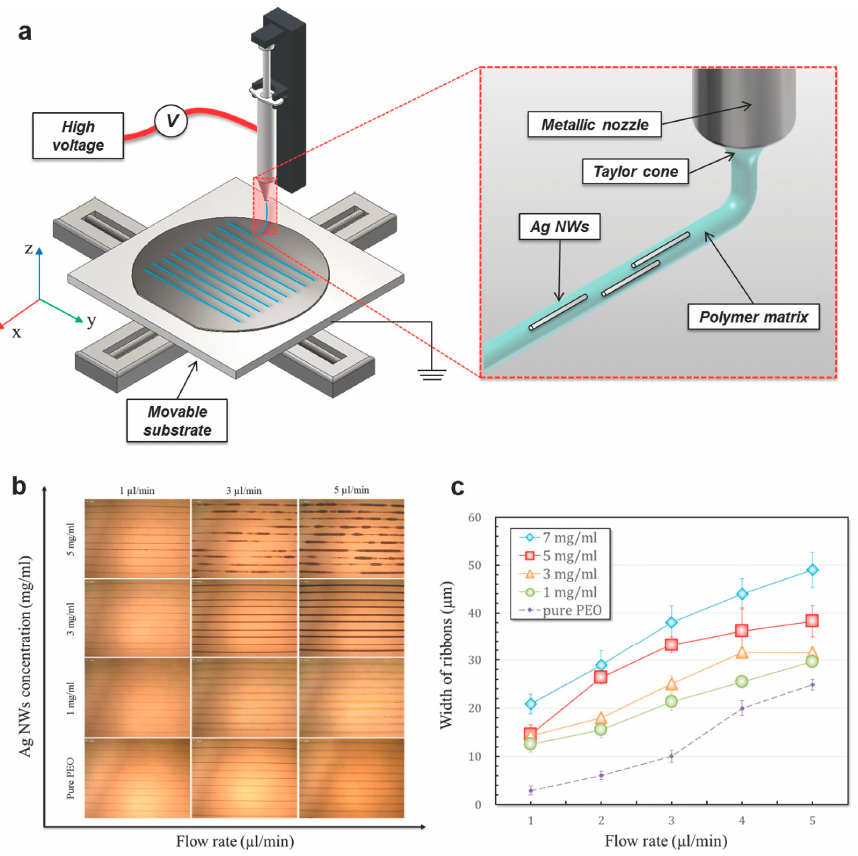
Figure 8. ( a ) Schematic of experimental setup for electrohydrodynamic jet printing system; ( b ) EHD jet printed ribbons with various concentrations and flow rates; ( c ) correlation between width of ribbons and the flow rate. Reproduced with permission from Ref. [47]. Copyright 2014,